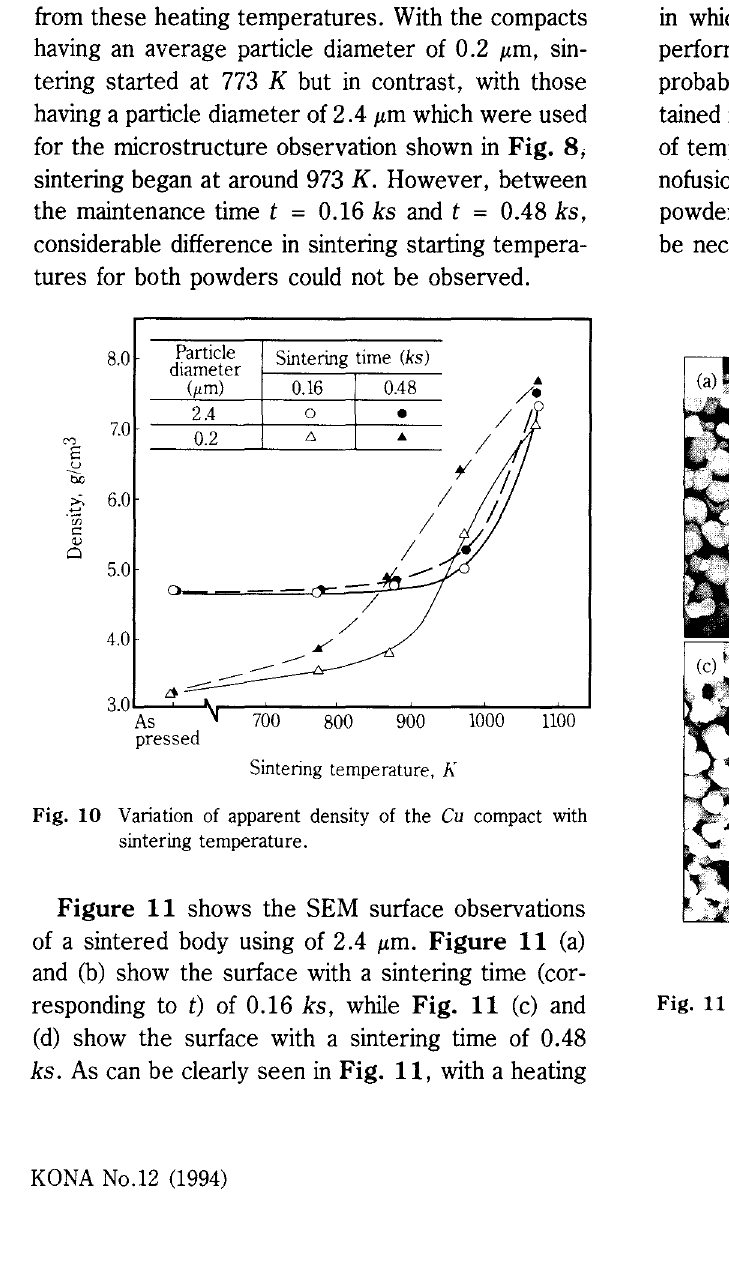
Fig. 11 Change in appearance of Cu compacts with sintering time and temperature (a) t = 0.16 ks, T = 973 K, (b) t = 0.16ks, T = 1073 K (c) t = 0.48 ks, T = 873 K, (d) t = 0.48 ks, T = 973